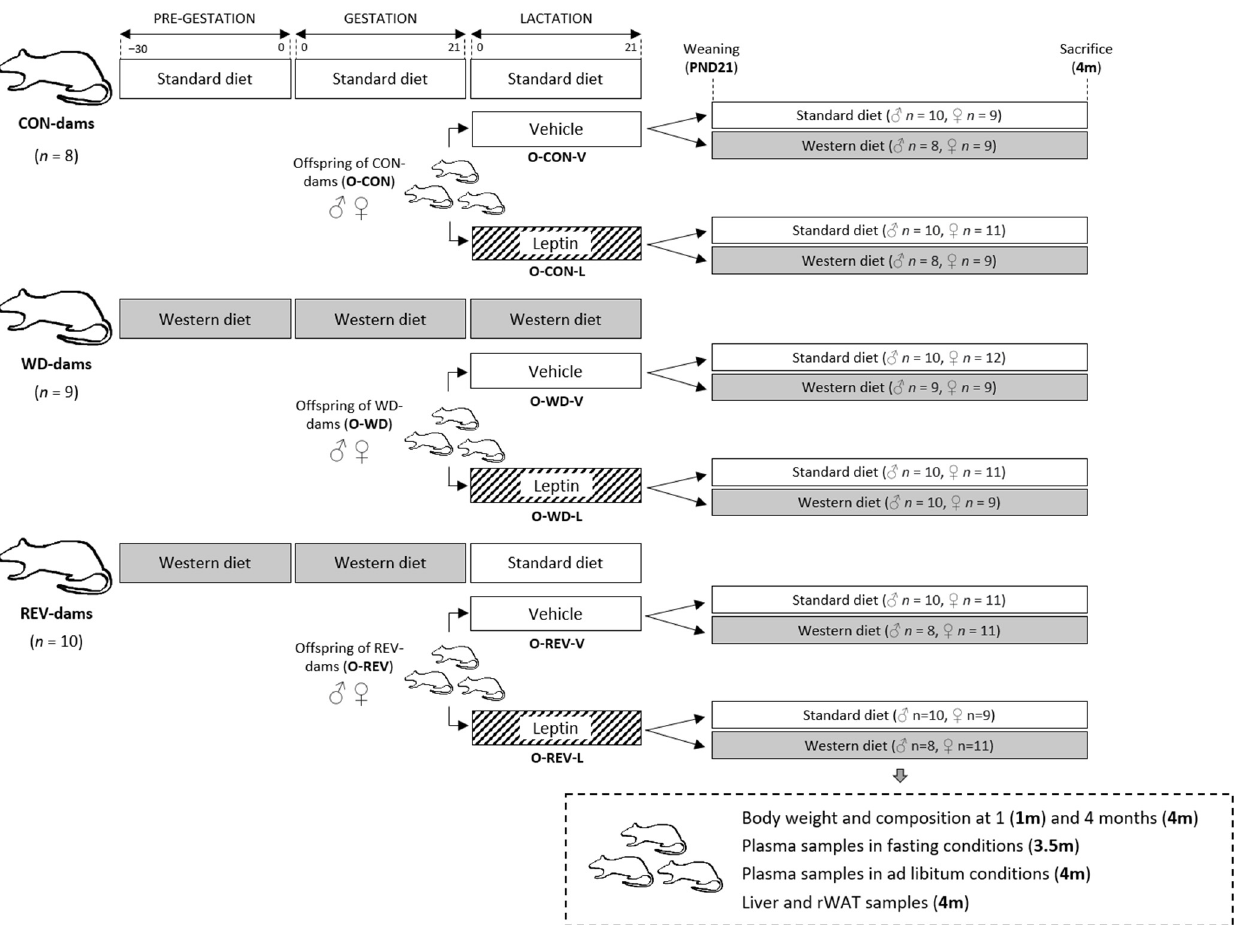
Figure 1. Representative scheme of the experimental design. Abbreviations: control dams (CON-dams), western diet dams (WD-dams), reversion dams (REV-dams), offspring of CON-dams (O-CON), offspring of WD-dams (O-WD), offspring of REV-dams (O-REV), vehicle (V), leptin (L), retroperitoneal white adipose tissue (rWAT).